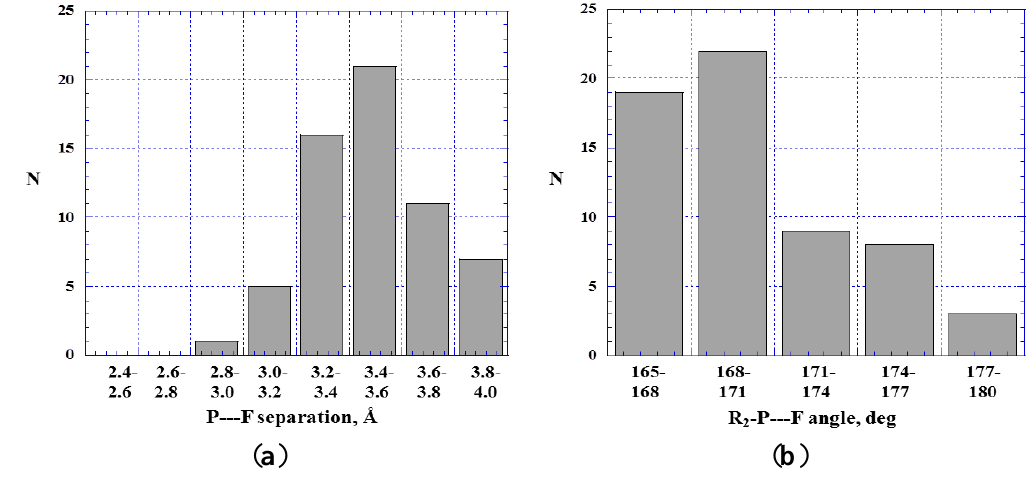
Figure 9. Histograms showing numbers N of 1.0 V. ---F– close contacts at various P---F separations ( a ) and R –P---F angles ( b ). 2